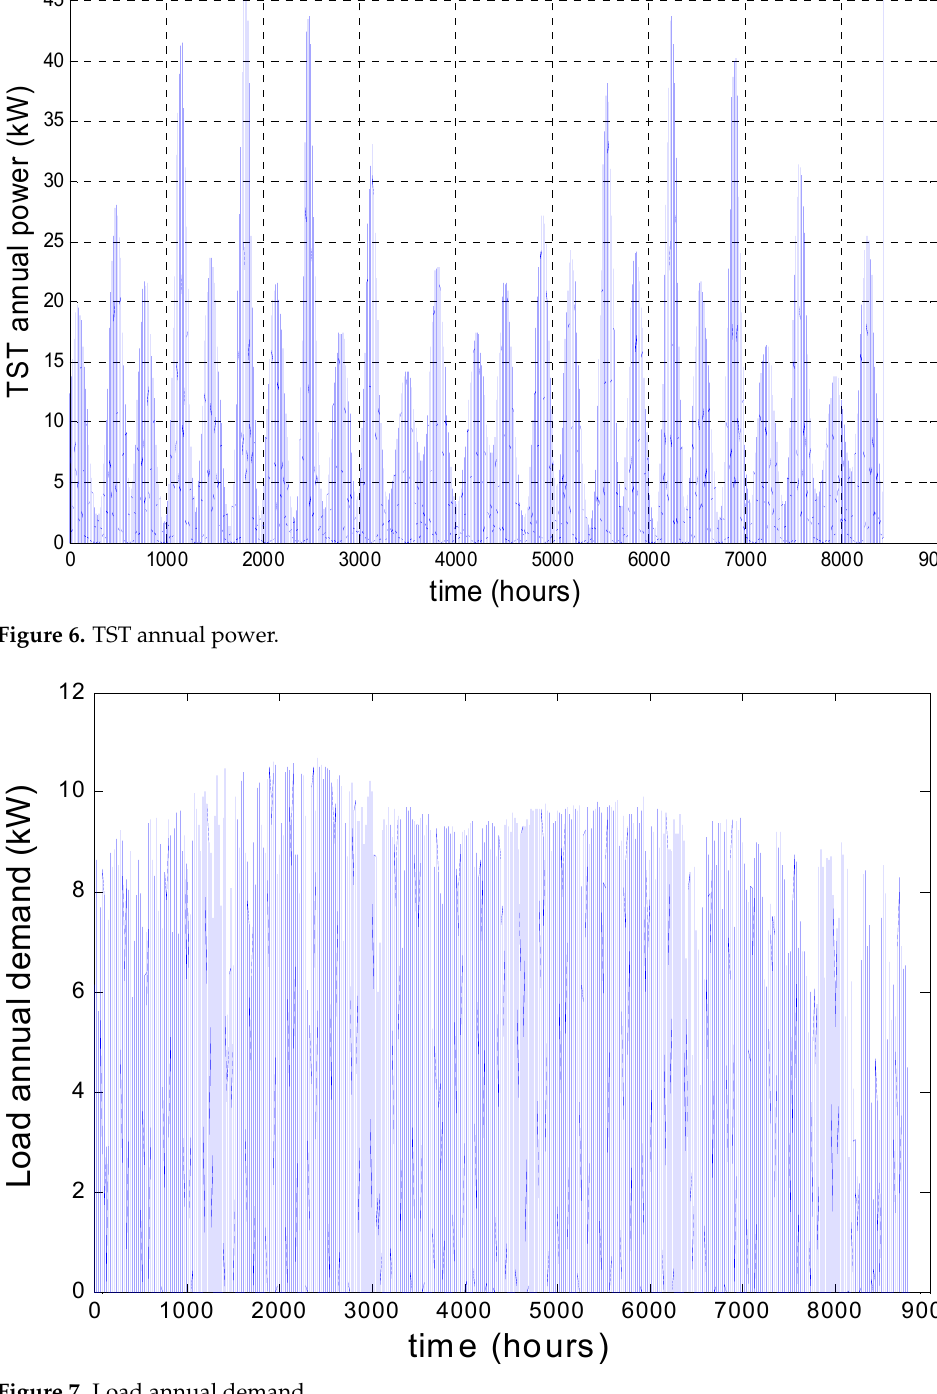
Figure 7. Load annual demand.